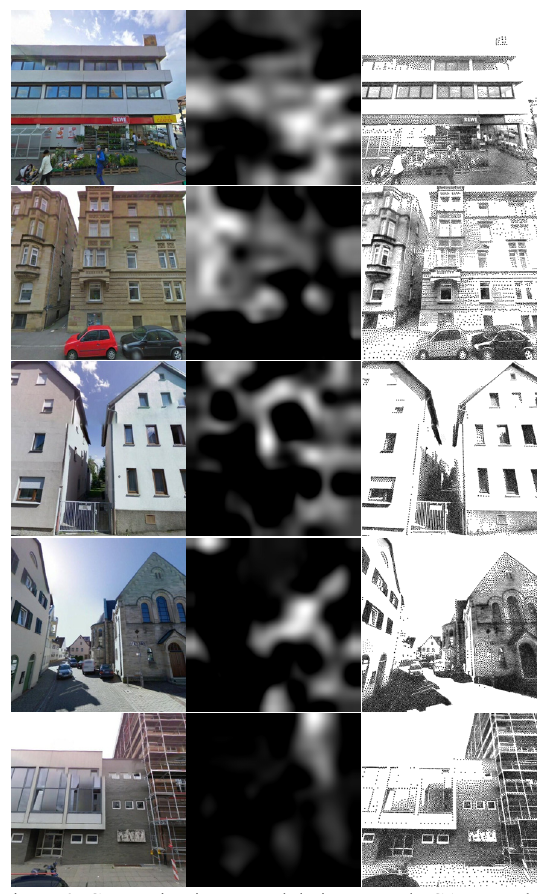
Figure 9. Comparing inputs and their grayscale CAMs to the stippled results for all classes (top-down: commercial , hybrid , residential , specialUse , underConstruction